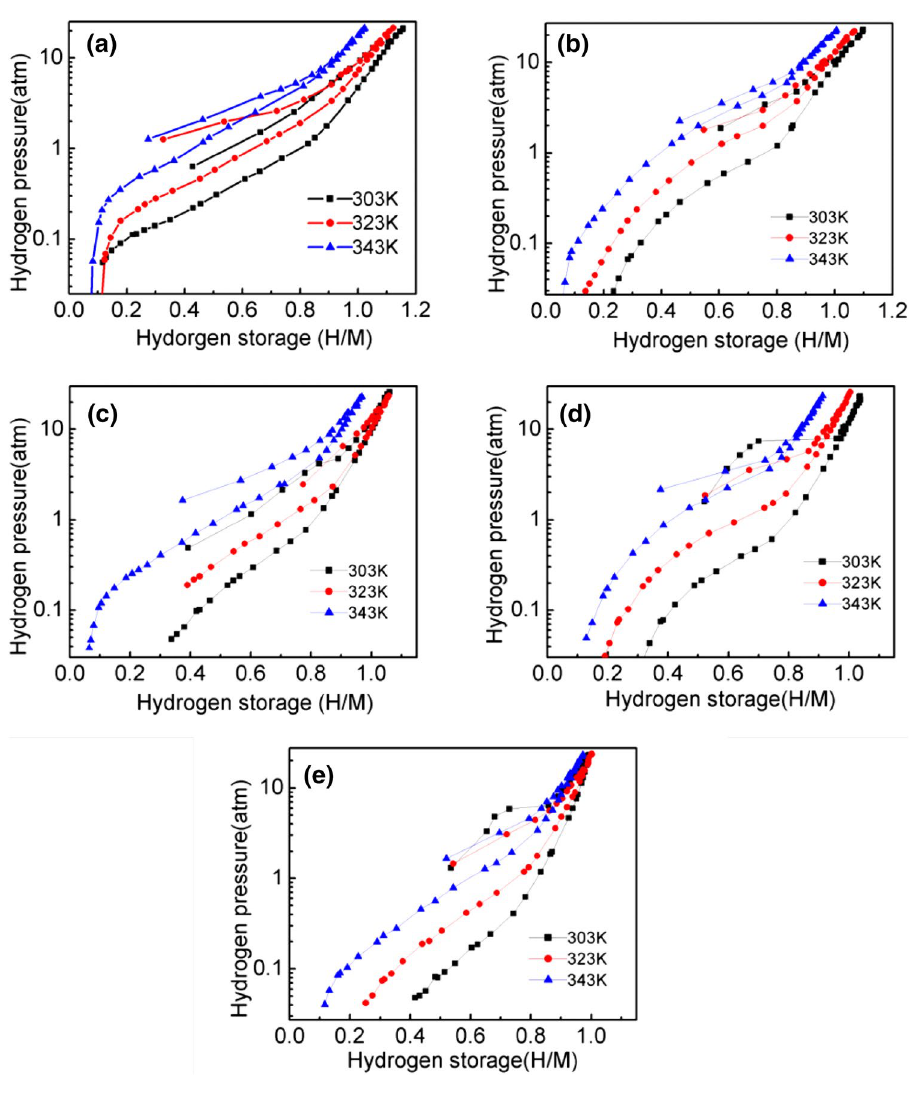
Fig. 3 P–C–T curves of